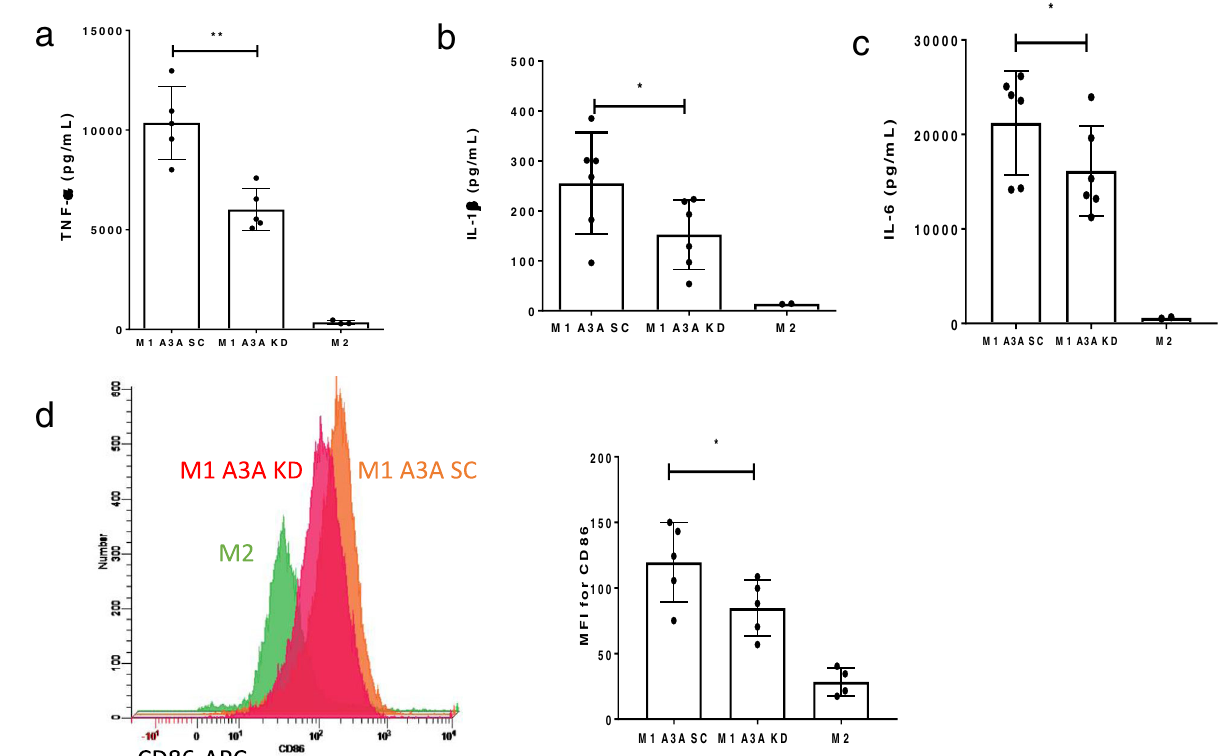
Fig. 6 Knockdown of A3A impairs pro-in fl ammatory phenotype of M1 macrophages. a A3A KD decreases TNF- α secretion by M1 macrophages from normal donors compared to controls (SC). P = 0.0049, Paired t test, two-tailed, n = 5 donors. b A3A KD decreases IL-1 β secretion by M1 macrophages from normal donors compared to controls (SC). P = 0.0103, Paired t test, two-tailed, n = 6 donors. c A3A KD decreases IL6 secretion by M1 macrophages from normal donors compared to controls (SC). P = 0.0192, Paired t test, two-tailed, n = 6 donors. d A3A KD reduces CD86 surface protein expression in M1-macrophages by fl ow cytometry. Cytokines are measured by ELISA (see the “ Methods ” section). e The quanti fi cation of CD86 ( P = 0.0395, Paired t test, two-tailed, n = 5 donors) is made using fl ow cytometry (see the “ Methods ” section) following M1 polarization in CD33-positive cells. MFI = mean (geometric) Fluorescent Intensity. M2 macrophage data from a smaller number of donors ( n = 2 – 4) highlight low expression levels of in fl ammatory markers in M2. Data in scatter dot plots with mean ±